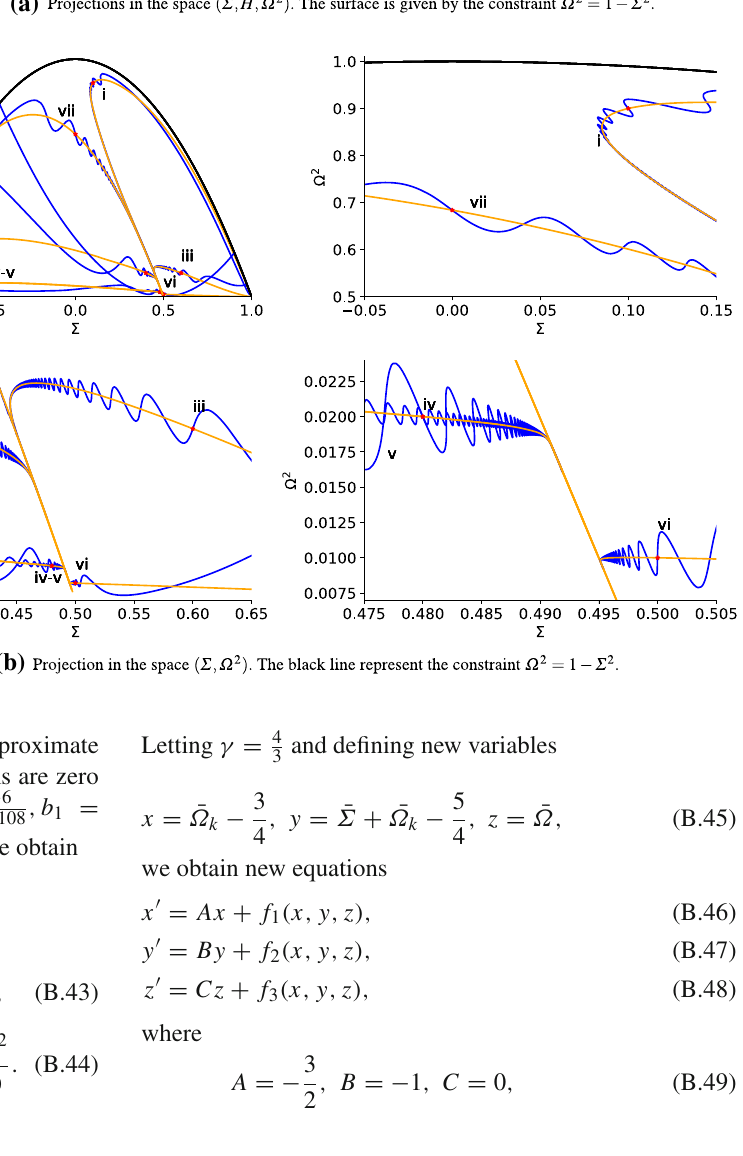
Fig. 12 Some solutions of the full system (46) (blue) and time-averaged system (78) (orange), corresponding to LRS Bianchi III metric, when γ = b = f = 0, ω 2 = 2, μ = 1, Ω = 0 and m Ω = 1 − Σ 2 − Ω 2 , with the k identification Ω 2 (cid:15)→ Ω , for which the results of [152] are recovered. We have used initial data sets presented in the Table